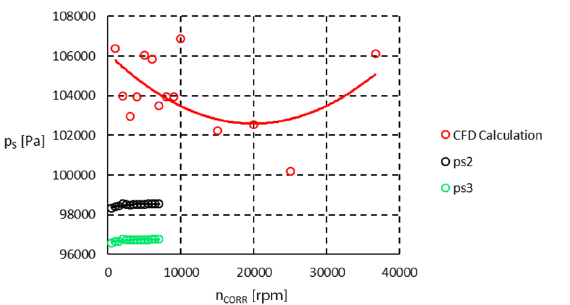
Figure 15. Total temperature comparison